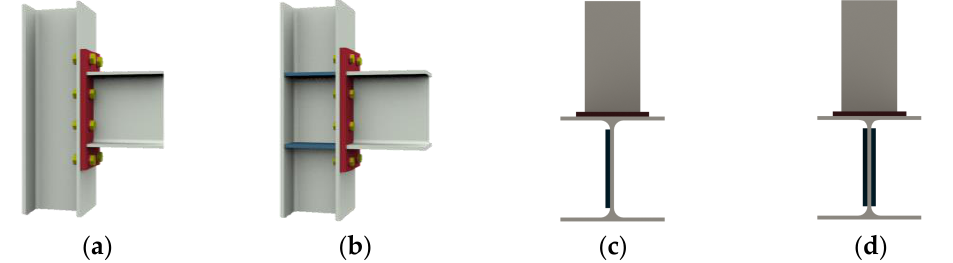
Figure 17. Different forms for web: ( a ) No reinforcement; ( b ) Continuity plates; ( c ) Single supplement plate; ( d ) Double supplement plates.